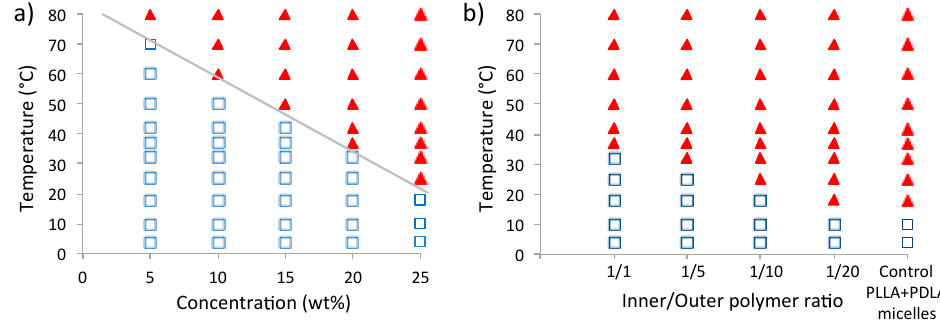
Figure 4. Sol-to-Gel phase diagram: variation of: ( a ) total polymer concentrations with constant 3LM inner:outer = 1/1; and ( b ) 3LM composition of inner:outer ratios with constant polymer concentration at 20 wt % (open square: solution state, closed triangle: gel state by tilt method).